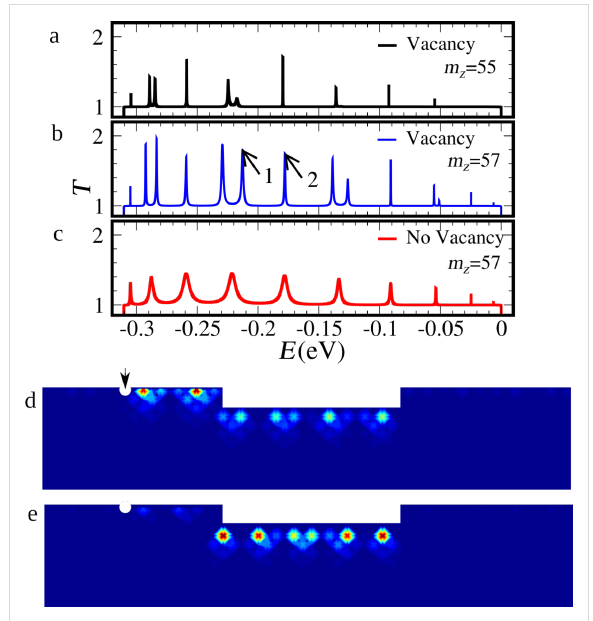
Figure 7: Edge states transmission probabilities for a nanoribbon N Z = 60 wide, with a constriction L = 10 long, adding an edge vacancy at the left contact: (a) m Z = 55 and (b) m Z = 57. (c) The system without vacancies for the sake of comparison, highlighting the splitting of the resonances due to the presence of a vacancy. (d) LDOS at the energy indicated by arrow 1 in panel (b). (e) LDOS at the energy indicated by the arrow 2 in panel